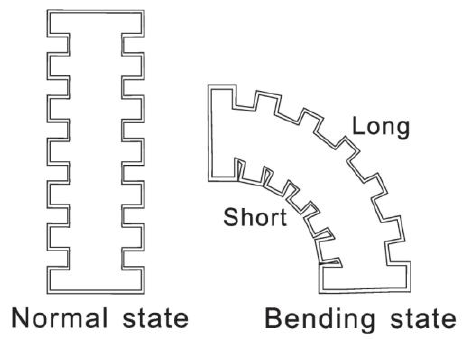
Figure 1. Working principle and corrugated tube